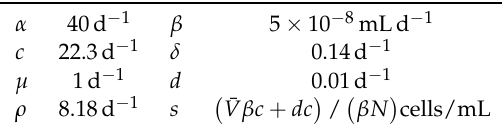
Table 2. Default parameters that are used herein. Parameter s comes from Equation (9), taking ¯ V as the max Virions